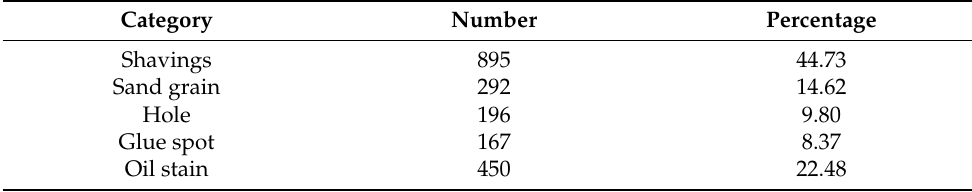
Table 1. Statistical data of the number and percentage of images of defect